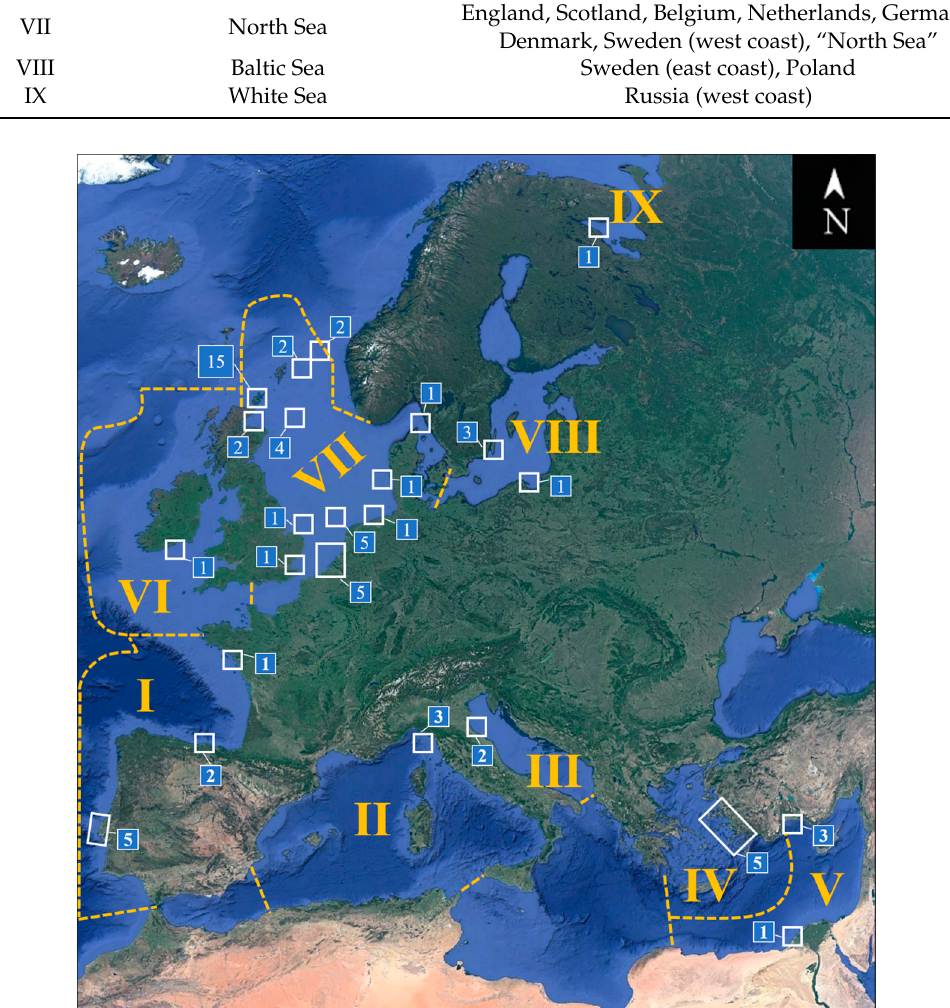
Figure 8. Overview of sites covered in the European biofouling database. Ecoregions key (yellow Roman numerals): I , South European Atlantic Shelf; II , Western Mediterranean Sea; III , Adriatic Sea; IV , Aegean Sea; V , Levantine Sea; VI , Celtic Seas; VII , North Sea; VIII , Baltic Sea; and IX , White Sea. Sites key (white squares): area and number of biofouling sampling records (surveys undertaken at different sites or during different periods at the same site). Base map: Google Earth. Table 3. Overview of the origin of the data used to generate the biofouling database. Region